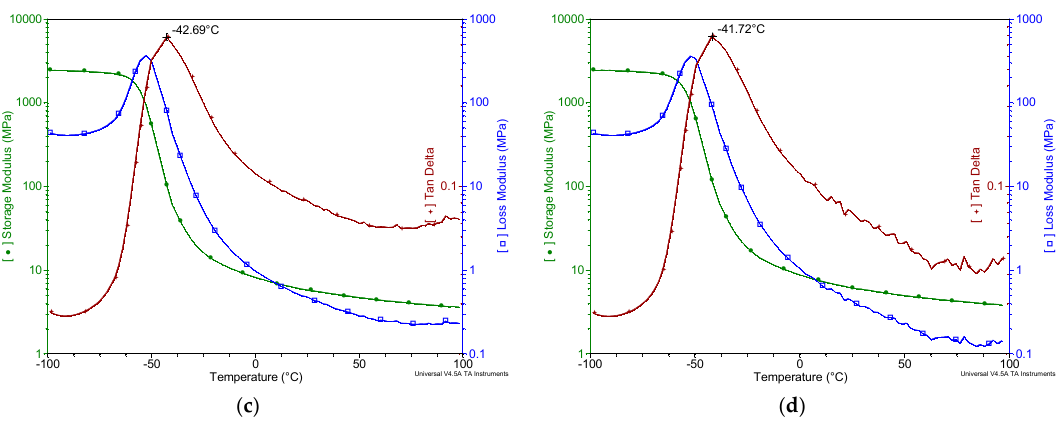
Figure 2. Dynamic mechanical analysis (DMA) results for various excitation frequencies: ( a ) 1